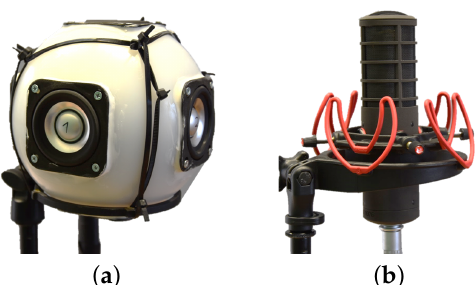
Figure 2. Compact arrays that are used to measure the multiple input multiple output (MIMO) room impulse responses (RIRs). ( a ) Cubelet: Spherical ( r = 7.5cm) 6-channel loudspeaker array prototype with loudspeakers arranged on surfaces of a cube. ( b ) TSL ST450: 4-channel Ambisonic B-format microphone array with r =